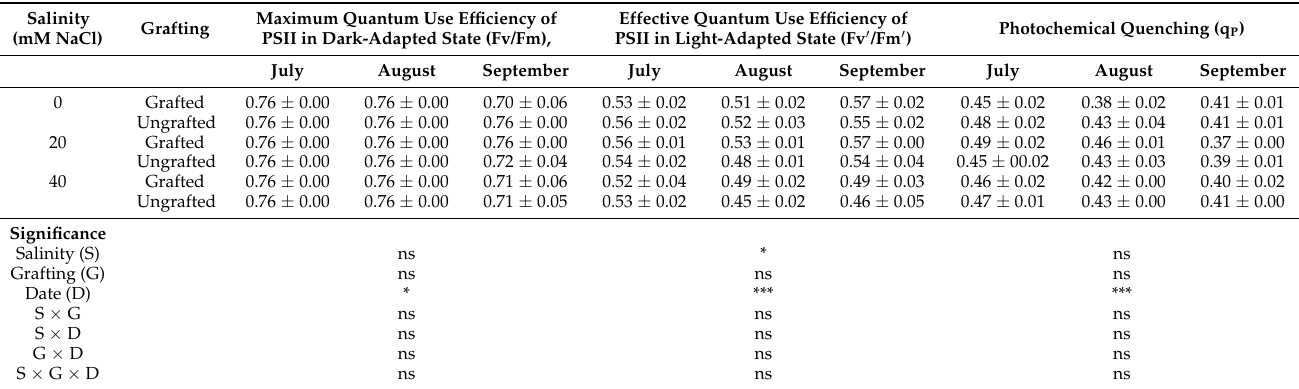
Data are means ± standard errors (n = 3). Symbols indicate significant differences between treatments; *, p < 0.05; ***, p < 0.001; ns, not significant (ANOVA).